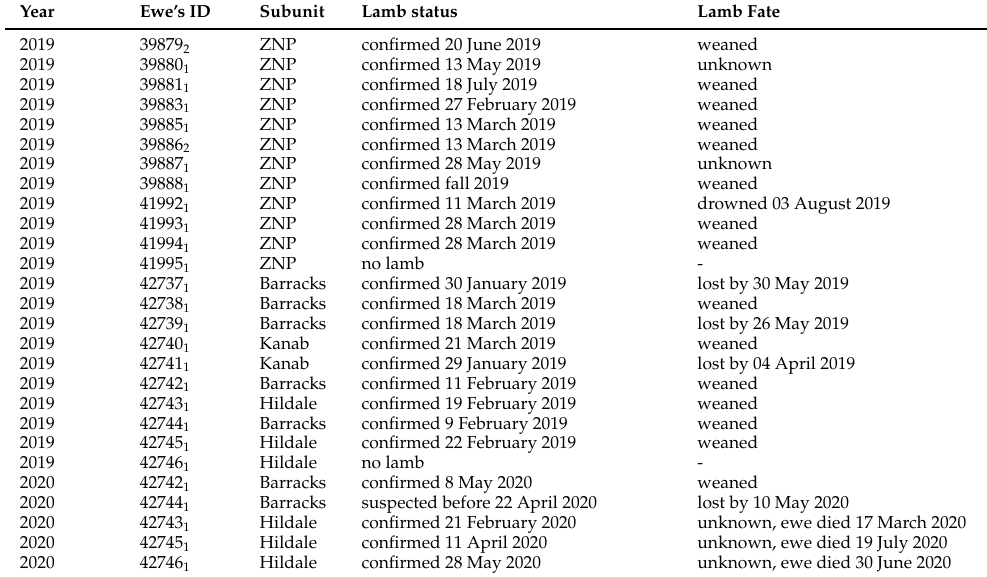
Table A2. Lamb fates 2019 and 2020. Subscripts indicate collar deployment number (e.g., 39879 2 is the second deployment of collar